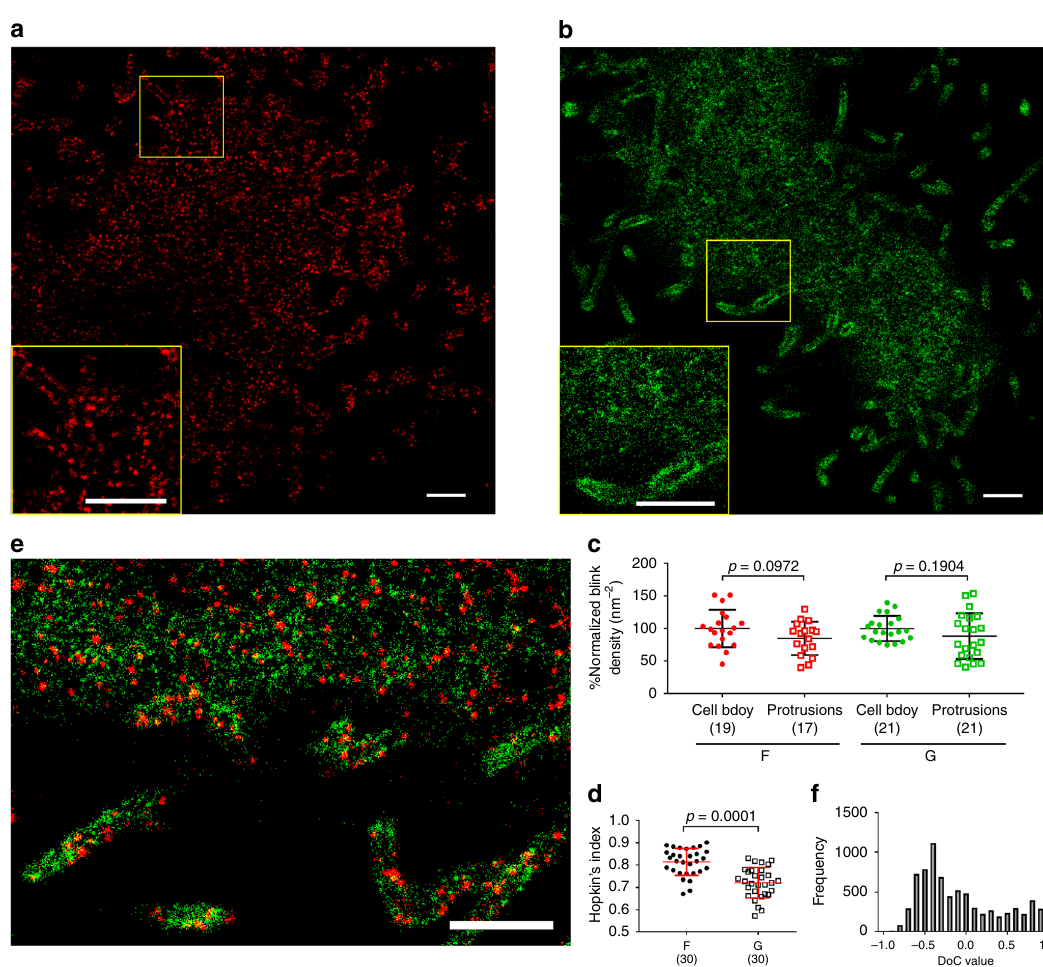
Fig. 2 Distribution of NiV envelope glycoproteins on the plasma membrane of PK13 cells. PK13 cells expressing NiV-F or/and -G were fi xed at 24 h post transfection and immunostained. Without permeabilization, NiV-F was immunostained by using a mouse anti-FLAG primary antibody and -G a rabbit anti- HA primary antibody. For single-color SMLM, Alexa Fluor 647 secondary antibodies were used for detection. For dual-color SMLM, Alexa Fluor 647 secondary antibodies were used for detection of F, and Cy3B secondary antibodies for G. a , b x – y cross section (100 nm thick in z ) at the dorsal surface (position 3 in Fig. 1a) of a representative cell expressing F ( a ) or G ( b ). The boxed region is enlarged to show the detailed distribution pattern. c Comparison analyses of the localization densities of the F (red) or G (green) at the cell body versus membrane protrusions. Each data point was calculated using an area of 0.2 × 0.2 μ m 2 . All data were normalized to the mean of the cell body. d Hopkins ’ index of the F and G localizations from n = 30 cells. Lines represent the mean value and SD. The sample size is indicated in the parentheses. The p values were determined by two-tailed, unpaired t -test with Welch correction. e x – y cross section (100 nm thick in z ) of a region at the dorsal surface (position 3 in Fig. 1a) of a representative cell co-expressing F (red) and G (green) with a pixel size of 10 nm. Scale bars: 1 μ m. f The distribution of the DoC values between F and G molecules. One representative cell image out of three independent experiments ( n ≥ 30) is